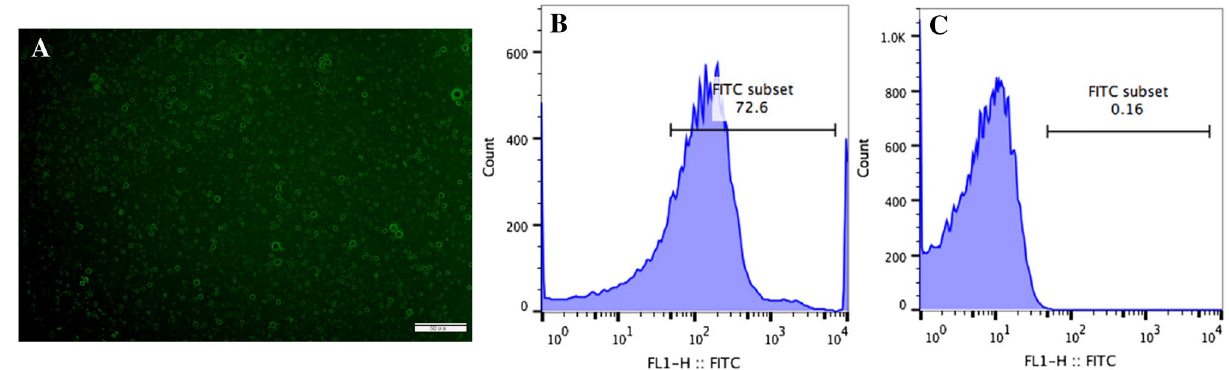
Figure 1. Images of ICAM-1-targeted ultrasonic nanobubbles under the fluorescence microscope ( A ). Scale bar shows 50 μm. Flow cytometry of microbubbles binding with ICAM-1 antibodies ( B ) and without ICAM-1 antibodies ( C